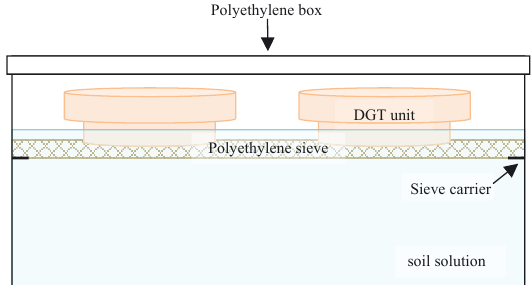
Figure 2. Design of the DGT units exposure to soil